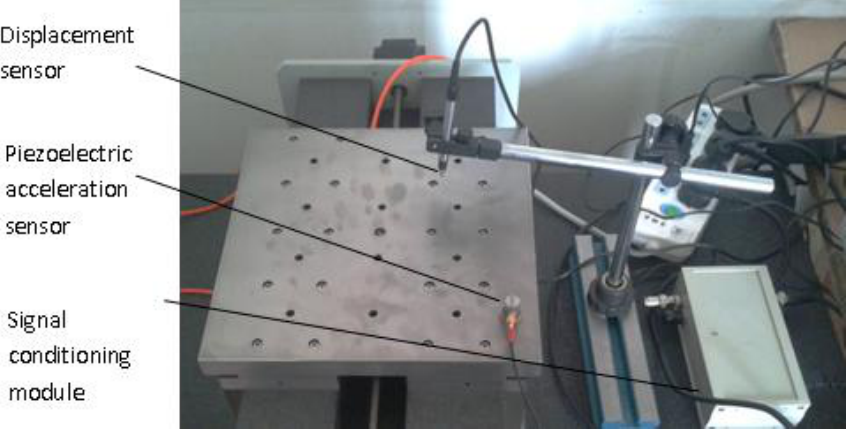
Figure 4. Measurement equipment of the gas